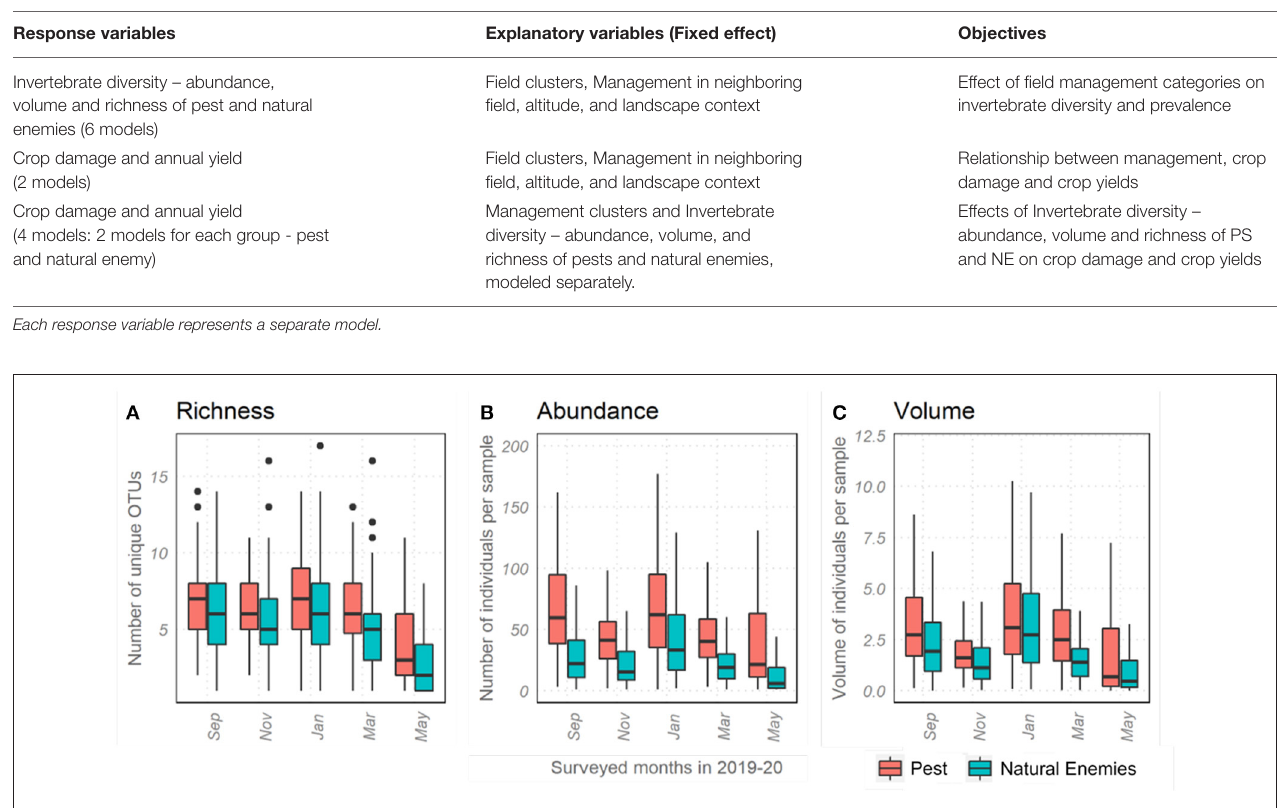
TABLE 2 | Response and explanatory variables included in the mixed-effects models with the month as a random effect.